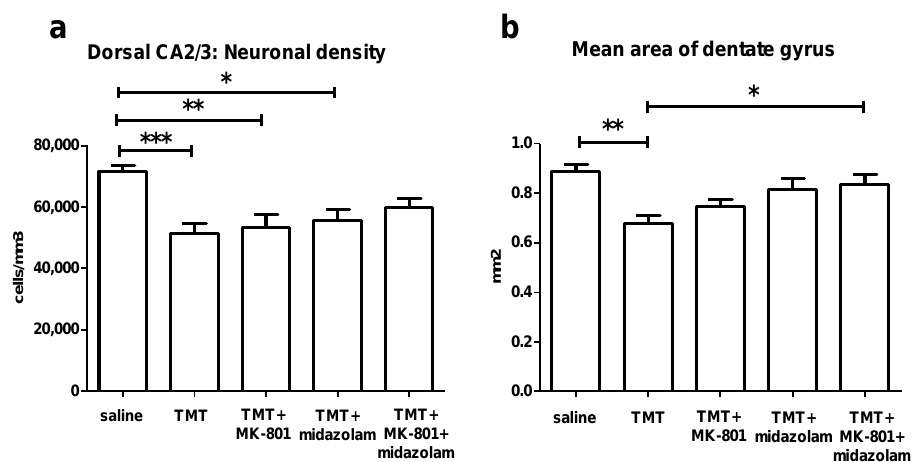
Figure 6. Histology. ( a ) Stereological estimate of neuronal density in CA2/3 in the defined portion of the dorsal hippocampus. Group mean + SEM. ANOVA and Tukey’s post hoc test, * p < 0.05, ** p < 0.01, *** p < 0.001. ( b ) Mean area of dentate gyrus (including the hilus, as described in Methods) in the defined portion of the dorsal hippocampus. ANOVA and Tukey’s post hoc test, * p < 0.05, ** p < 0.01.